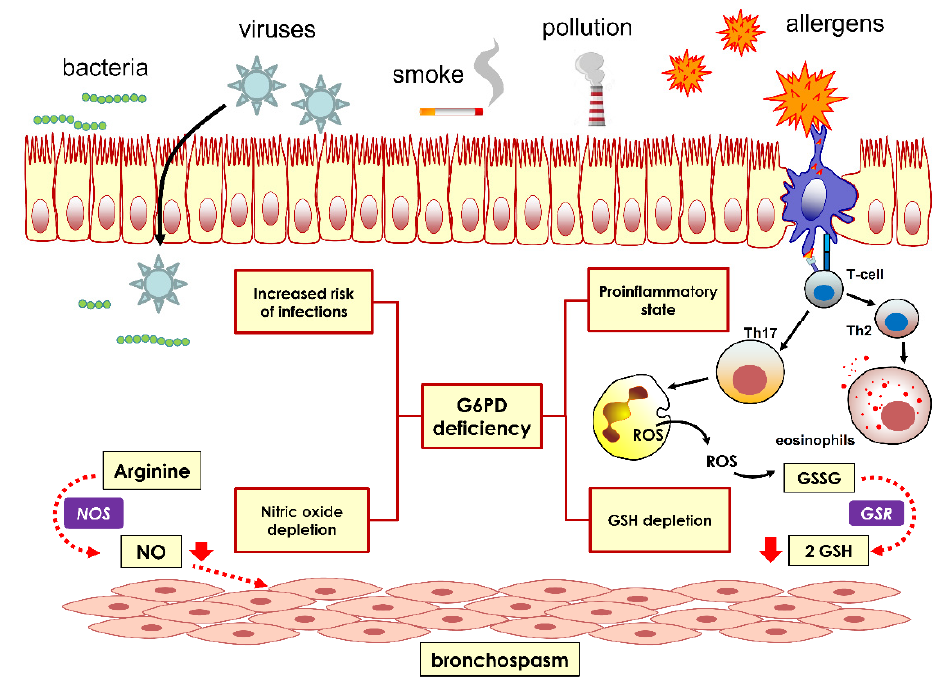
Figure 3. The putative role of G6PD deficiency in the pathogenesis of asthma. Nitric oxide (NO) production relaxes the smooth muscle of airways and vessels, inducing bronchodilation and vasodilation. G6PD deficiency induces bronchoconstriction by lowering NO generation by nitric oxide synthase (NOS). In addition, G6PD deficiency causes reduced glutathione (GSH) depletion, thus decreasing antioxidant defense and increasing the generation of free radicals.